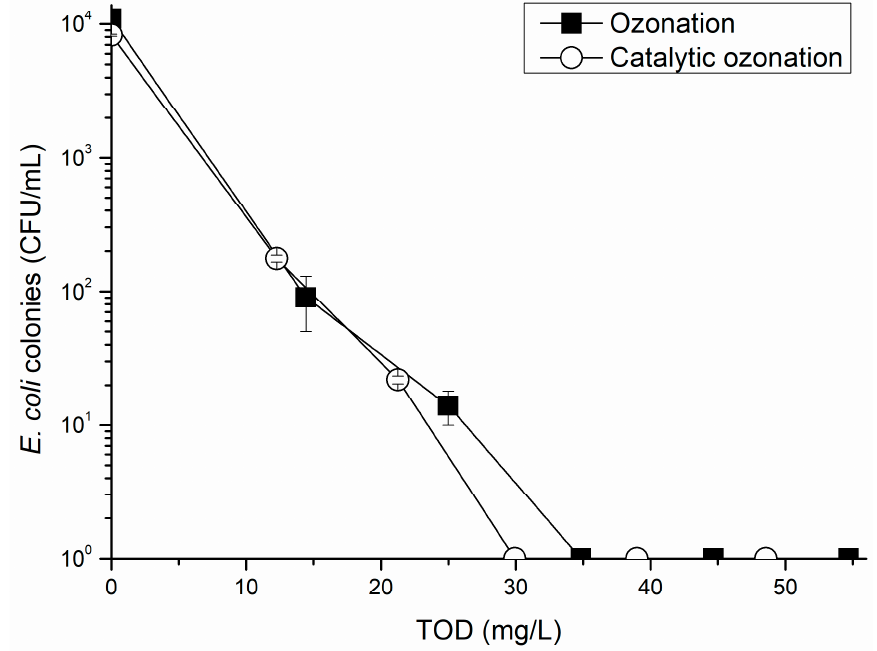
Figure 1. E. coli concentration using single and catalytic ozonation as function of TOD (using log 10 scale).